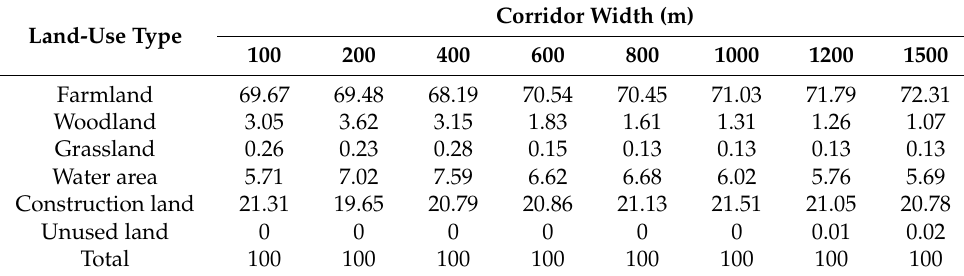
Table 5. Area of each landscape type based on